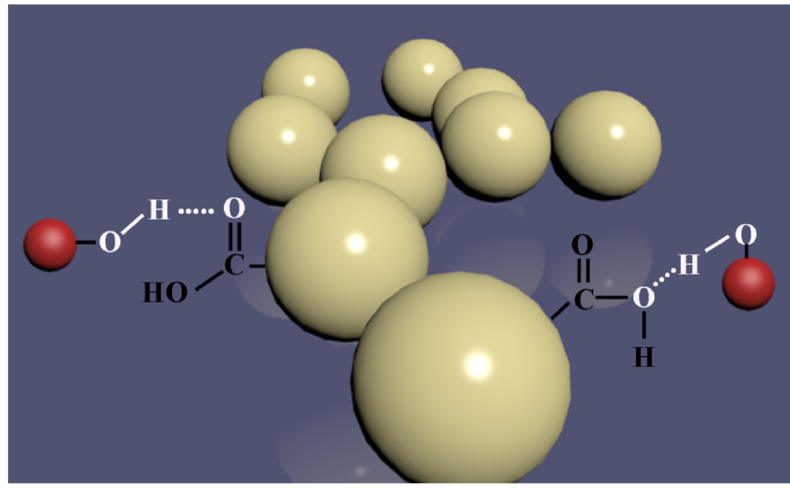
Figure 12. Schematic diagram of the hydrogen